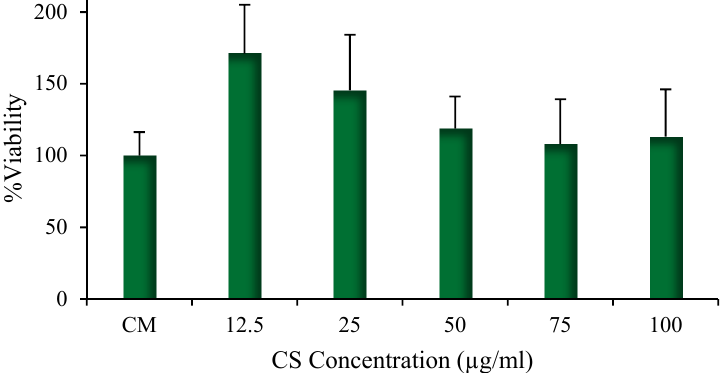
Figure 7. Viability of hMoCD14+-PB cells after 24 h contact with different NP amounts, expressed as CS-OA concentration (mean values ± s.d., n = 8).